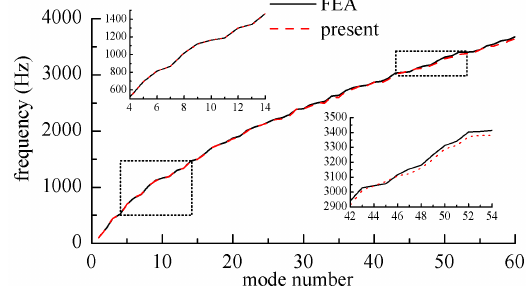
Figure 5. Nature frequency parameters for rectangular laminated plates with ECFF .